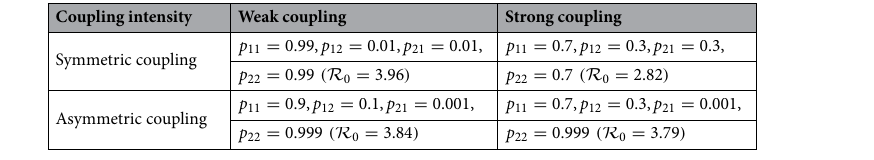
Table 2. Parameter values in a residence-time